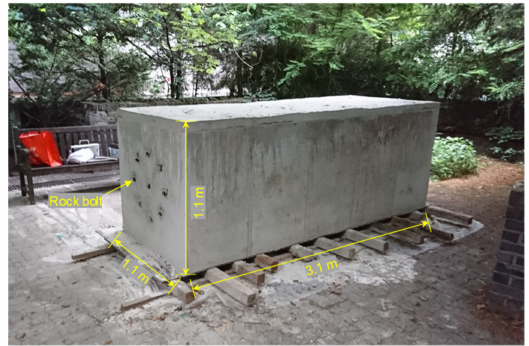
Figure 8. Concrete block with installed rock bolts for simulation of rock mass.